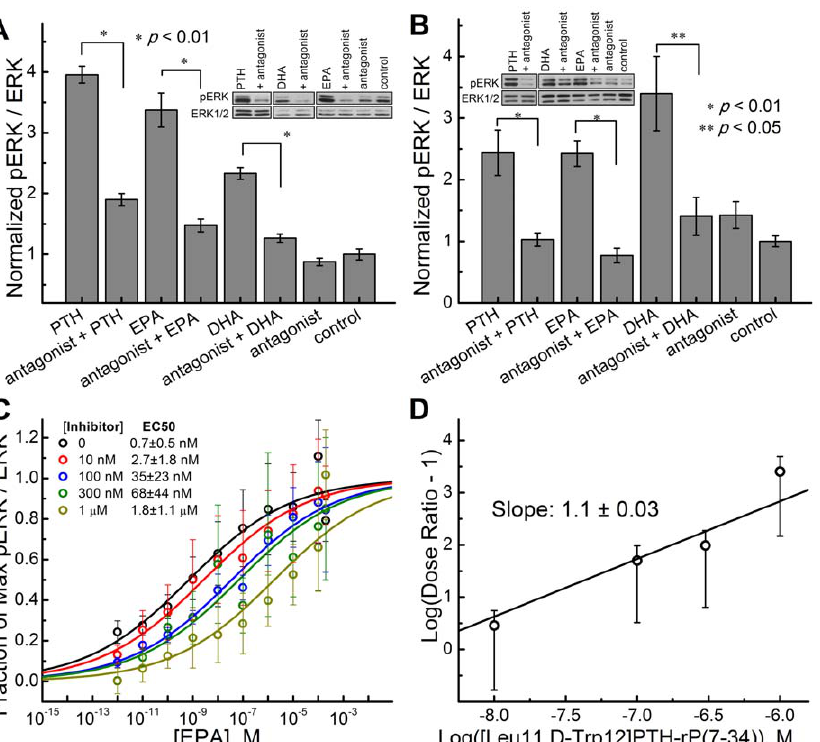
Figure 2. PTH1R antagonist inhibits ERK1/2 response to PTH(1–34) and fatty acids. (A) Effect of 1 m M of PTH1R antagonist [Leu 11 ,D- Trp 12 ]PTH-rP(7–34) on pERK stimulated with: 10 nM PTH(1–34), 1 m M EPA and 1 m M DHA in DPBS for 5 minutes in HEK293 cells transfected with PTH1R. (B) Effect of 1 m M of PTH1R antagonist, [Nle 8,18 ,Tyr 34 ]PTH(3–34), on pERK stimulated with 10 nM PTH(1–34), 1 m M EPA, and 1 m M DHA in MC3T3-E1 cells expressing endogenous PTH1R. (C) Dose response to EPA at different concentrations of antagonist [Leu 11 ,D-Trp 12 ]PTH-rP(7–34) in HEK293 cells. (D) Schild plot of [Leu 11 ,D-Trp 12 ]PTH-rP(7–34) antagonism on EPA-stimulated PTH1R in HEK293 cells. Experiments were done 24 h after transfection of HEK293 cells with PTH1R in 12-well plates. Ratio of pERK to ERK was measured using western blots. Data represents the mean of at least four independent experiments.